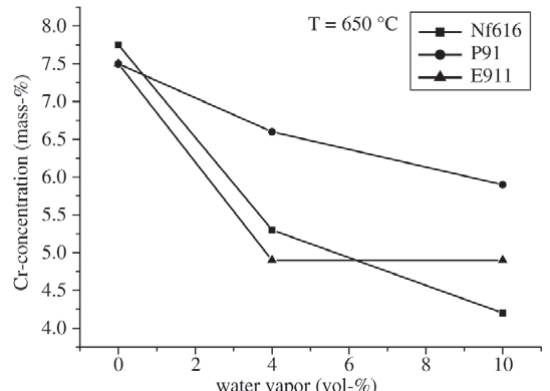
Figure 14. Minimum of Cr-concentration directly underneath the oxide scale as a function of the water vapour content at 650 °C after 10000